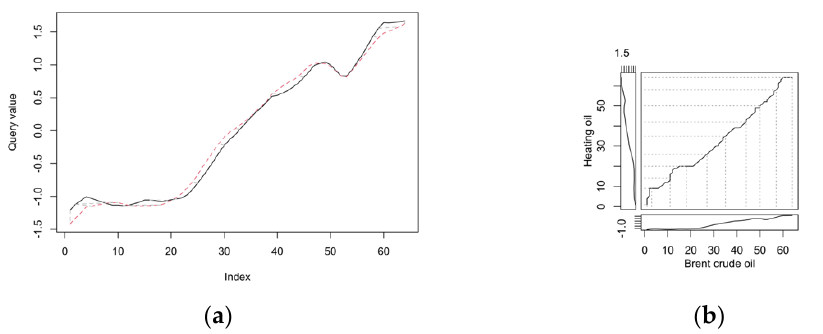
Figure 14. Alignment plots for crude oil and heating oil for the third subperiod. ( a ) Two-way, ( b ) three-way. On the two-way plot the black solid line for crude oil, the red dashed line for heating oil. Source: own elaboration on the basis of data from www.stooq.com (accessed on 19 April 2021).